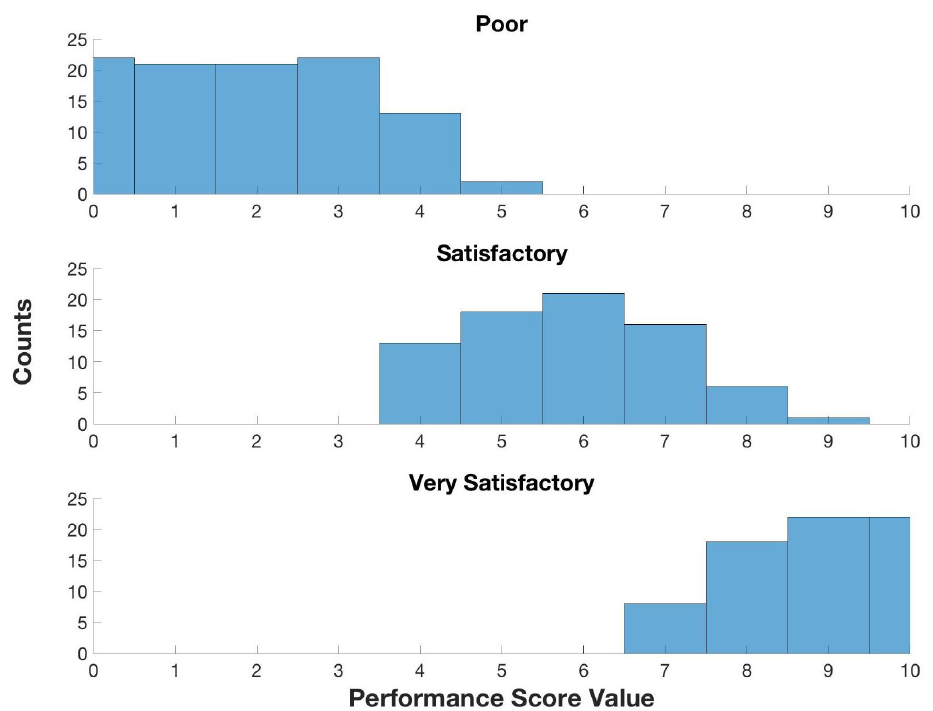
Figure A1. Histogram of polled data associating linguistic terms referring to an overall performance score with numerical values (3MF system).